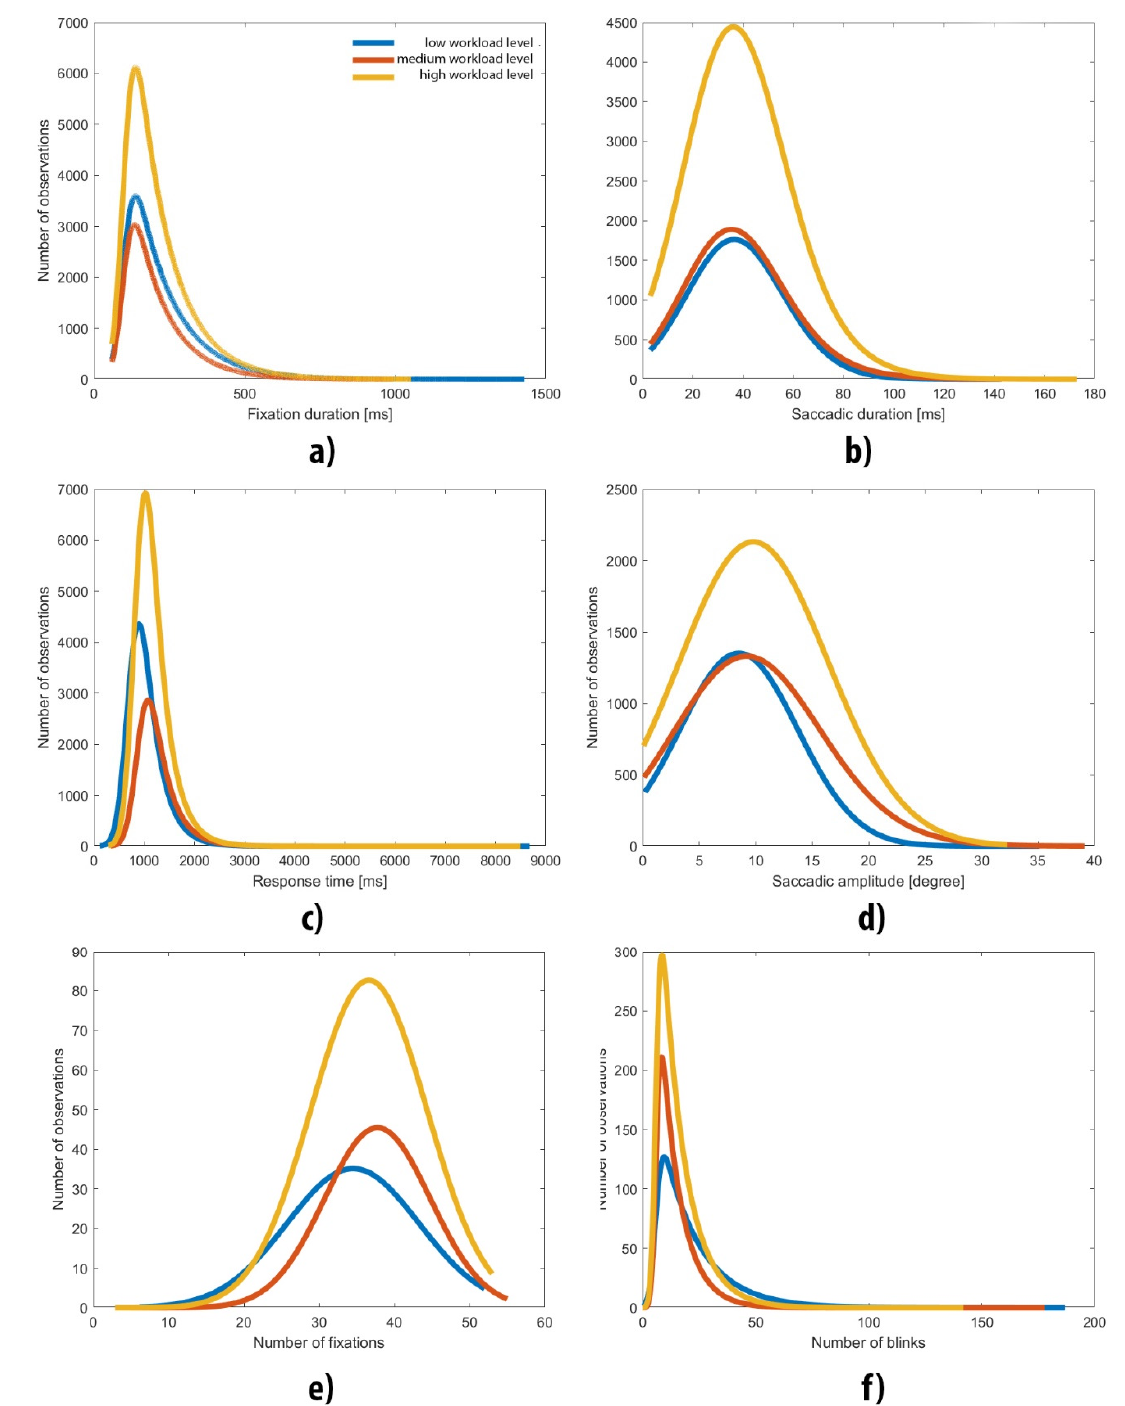
Figure 2. Distribution of features. Level 1 stands for low cognitive workload ( a )—fixation duration, ( b )—saccade duration, ( c )—response time, ( d )—saccade amplitude, ( e )—number of fixations, ( f )—number of